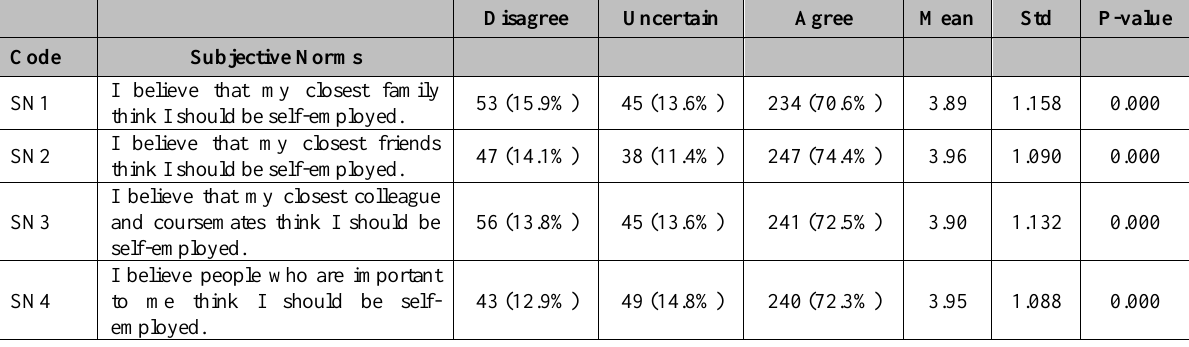
Table 6. Frequency Distribution of Perceived Subjective Norms on Entrepreneurship